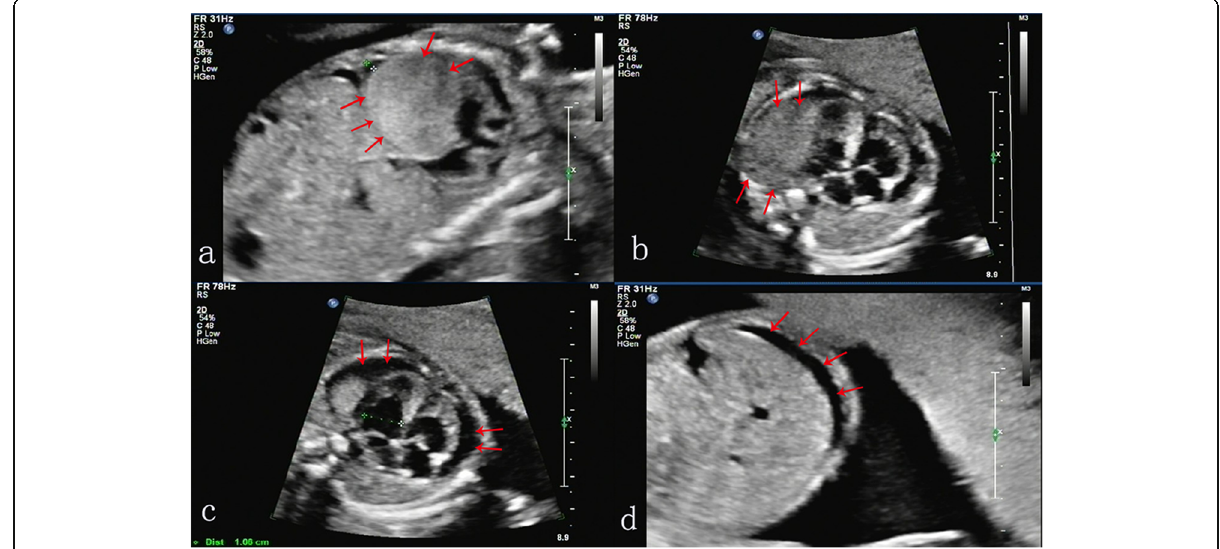
Fig. 3 The results of fetal ultrasound showed ( a , b ) cardiac rhabdomyosarcoma, ( c ) pericardial effusion, and ( d )